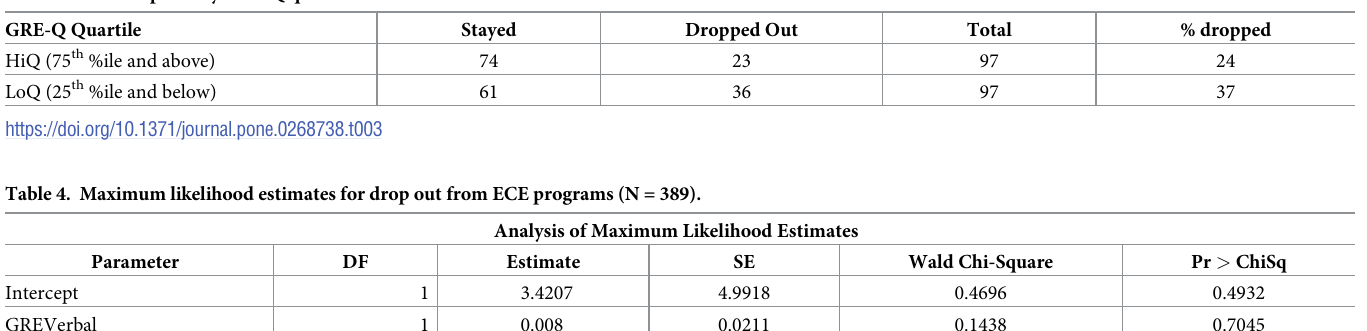
Table 3. ECE dropouts by GRE-Q quartile.